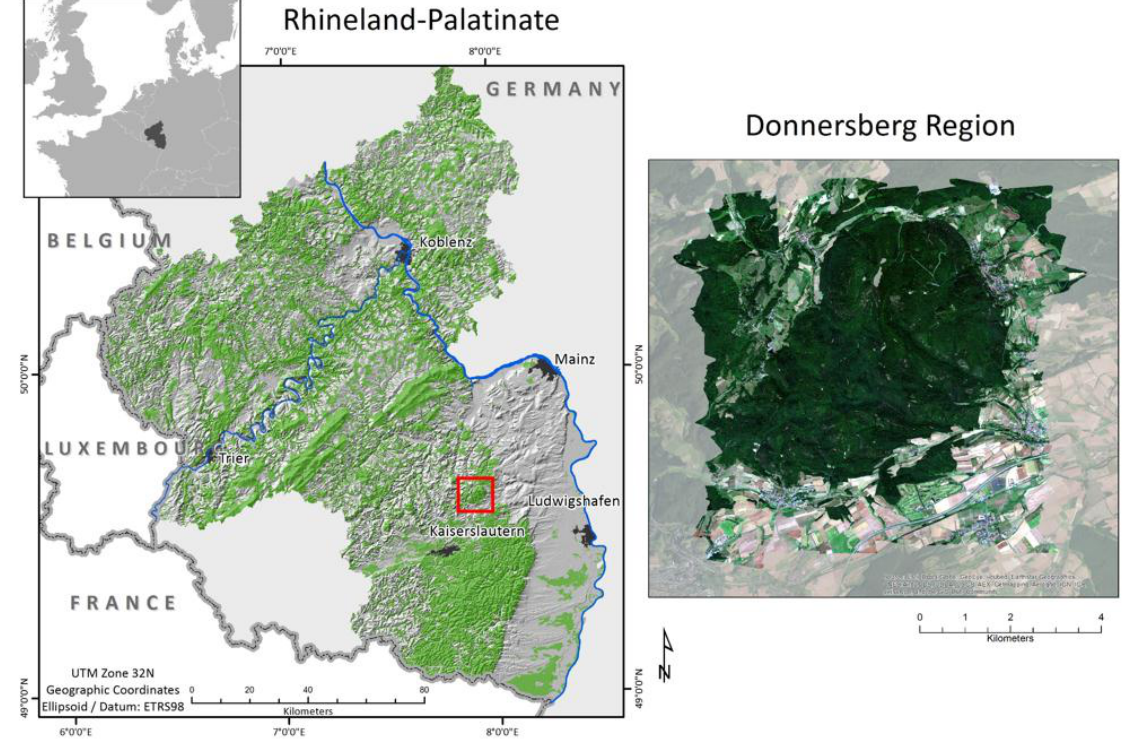
Figure 1. Location of the study area in the German state of Rhineland-Palatinate ( left ). Forested areas are displayed in green. The airborne mosaic of the Donnersberg area acquired on 3 July 2014 is displayed on the right